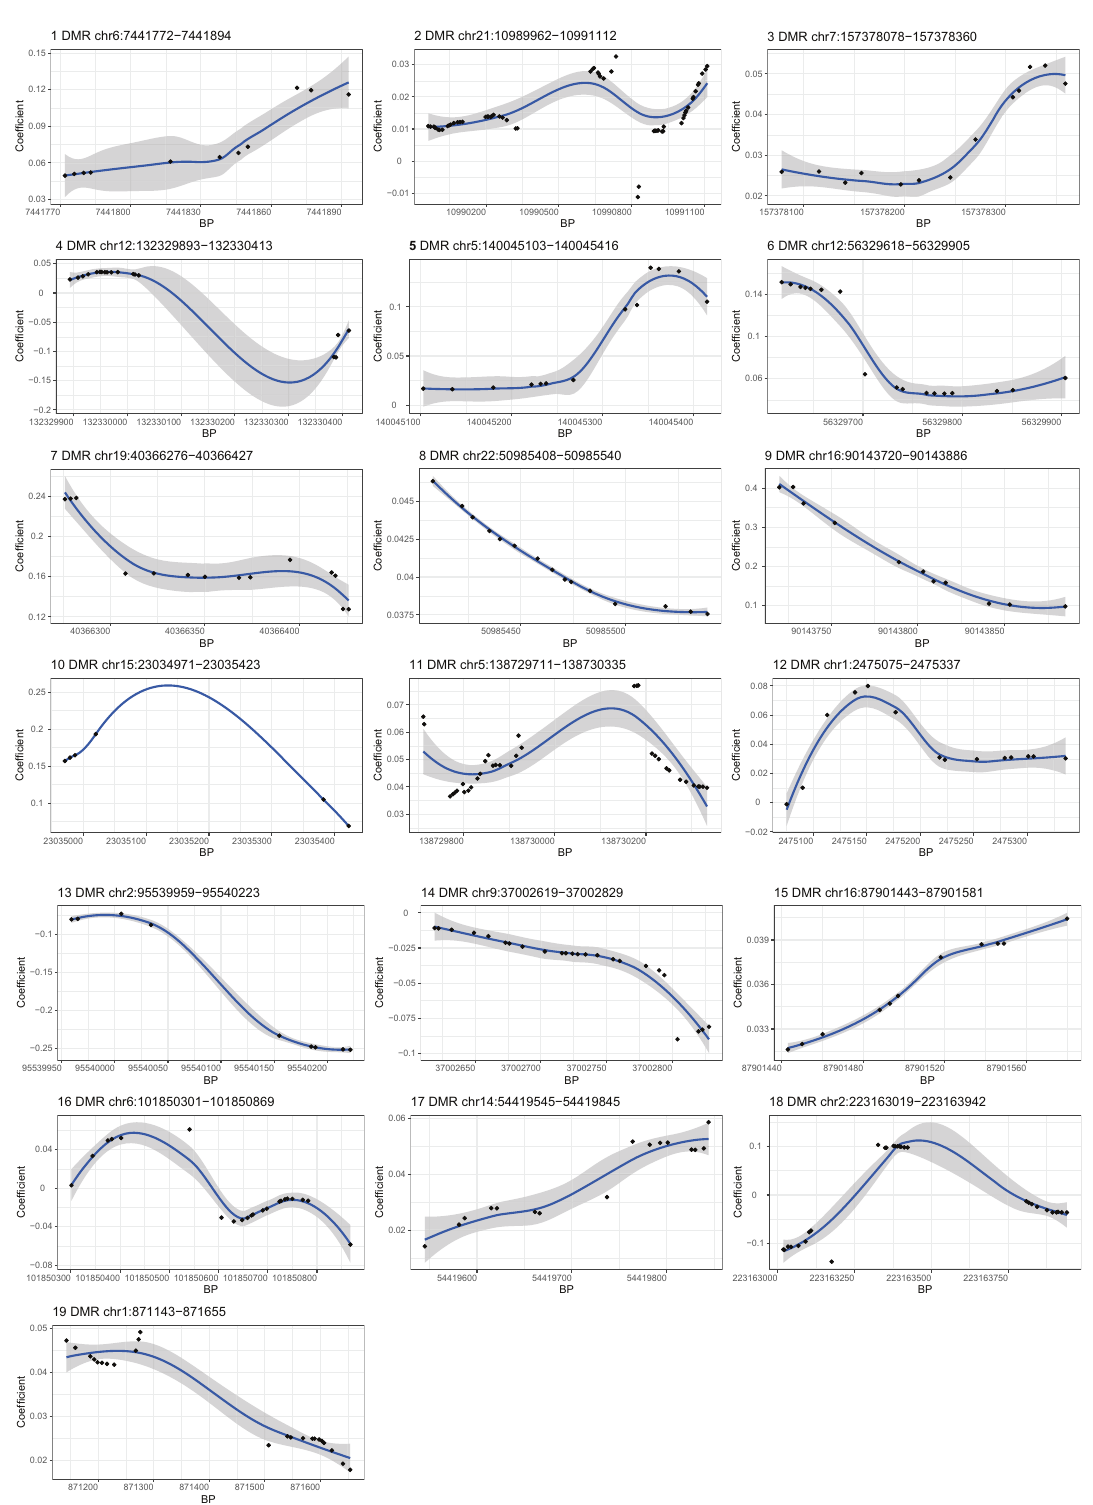
Fig. 2 Differential methylation patterns for the identi fi ed differentially methylated regions (DMRs). The horizontal axis shows the chromosome positions with the black point indicating each CpG, and the vertical axis shows the coef fi cient for the association of each CpG sites with depression score. The blue line indicates the methylation pattern for each DMR. BP, base pair; chr,